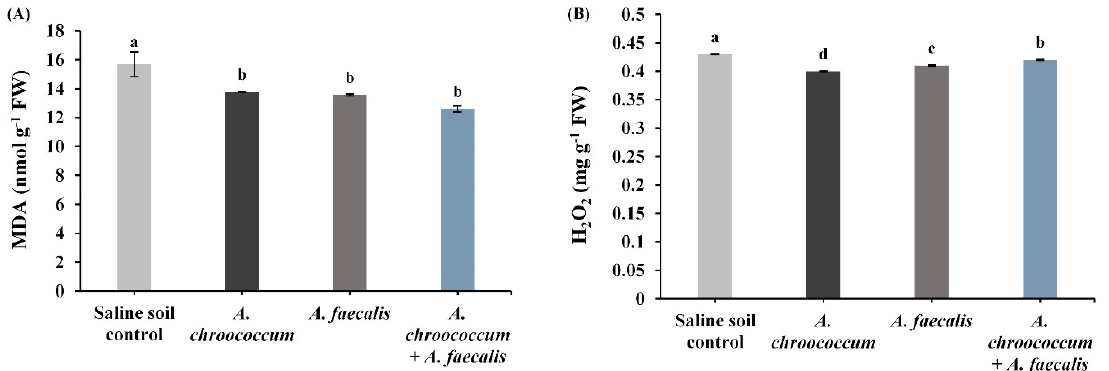
Figure 3. ( A ) Malondialdehyde (MDA) content and ( B ) hydrogen peroxide (H 2 O 2 ) content in canola plant fresh leaves inoculated with Azotobacter chroococcum , Alcaligenes faecalis , and their co-inoculation under salinity-stress conditions. Bars show means of three independent replications (n = 3) ± standard error. Means with the same letter are not significantly different at p < 0.05. FW: fresh weight.